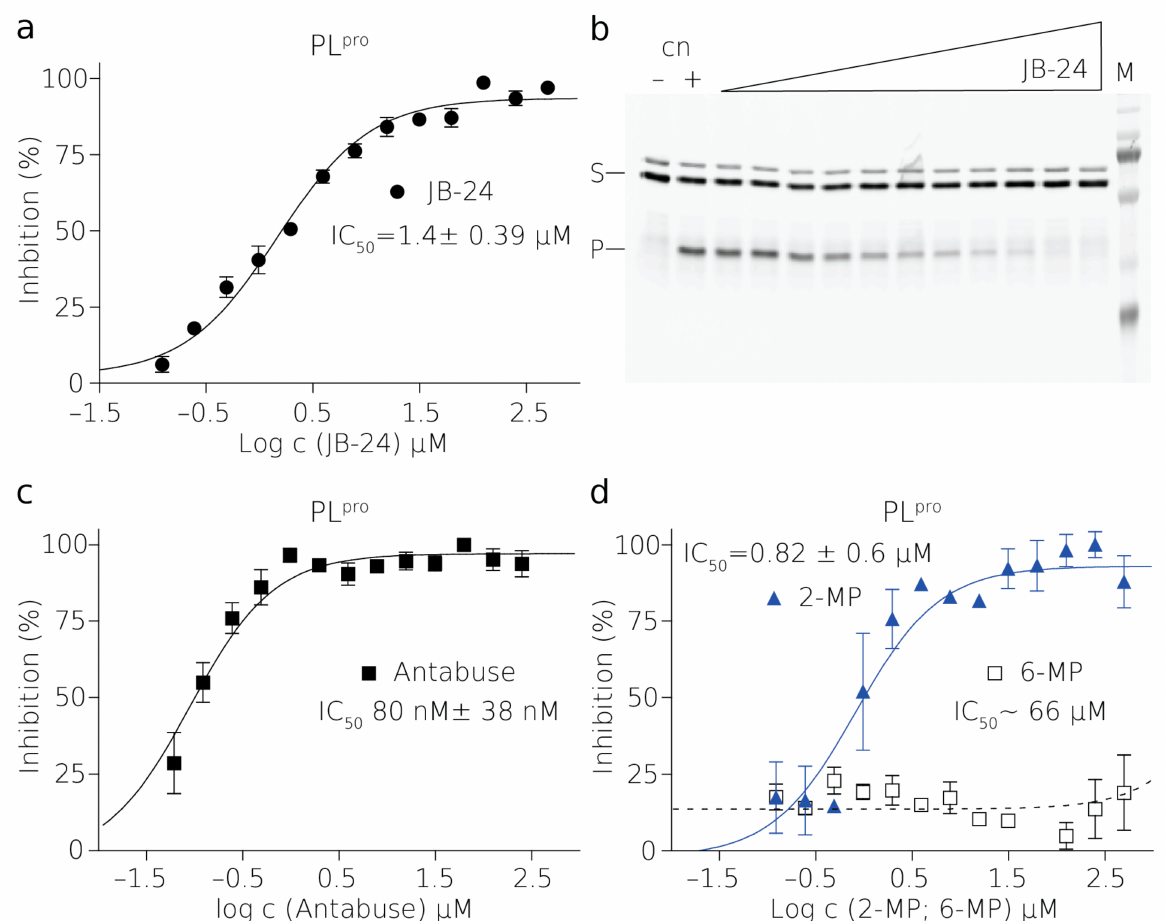
Figure 3. Inhibition of SARS-CoV2 PL pro by small molecules. Curves derived from the FRET inhibition assays of ( a ) JB24, ( c ) Antabuse, and ( d ) 2-MP and 6-MP. Each curve is derived from three experiments. ( b ) SDS-PAGE gel from one of the titrations with JB24 where (M) is a marker, (+) is a positive control reaction in which there was no inhibitor present, (–) is a negative control reaction where there was no enzyme present, (S) is the substrate, and (P) is the product. The illustrative evaluations of the SDS-PAGE gels resolving the reaction progress and more details are shown in Figure